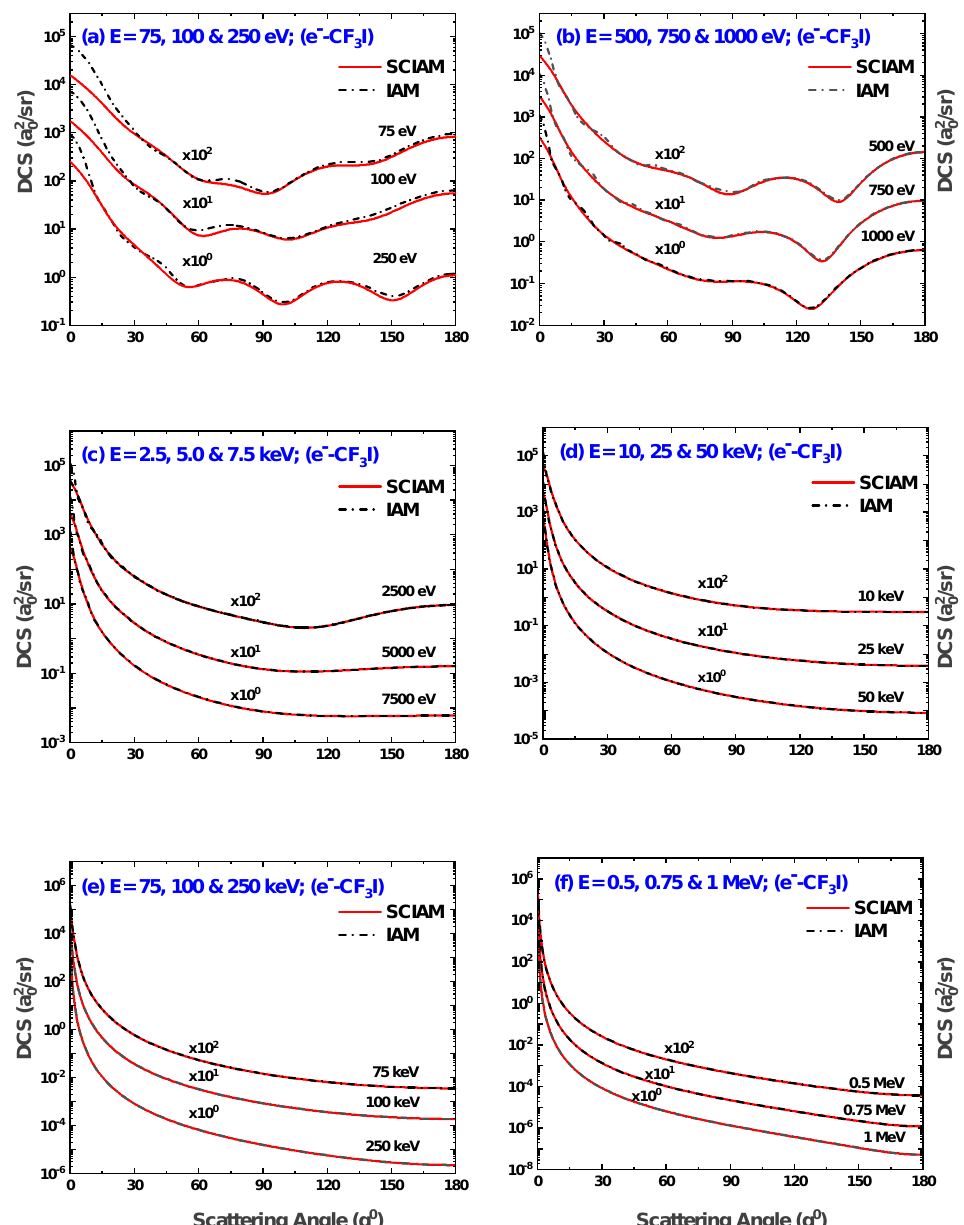
Figure 3. DCS ( a 2 / sr ) for the elastic scattering of electrons from CF 3 I at incident energies 75, 100, 0 250, 500, 750, 1000, 2500, 5000, 7500 eV, 10, 25, 50, 75, 100, 250 keV, 0.5, 0.75, and 1 MeV. Theoretical works: SCIAM,